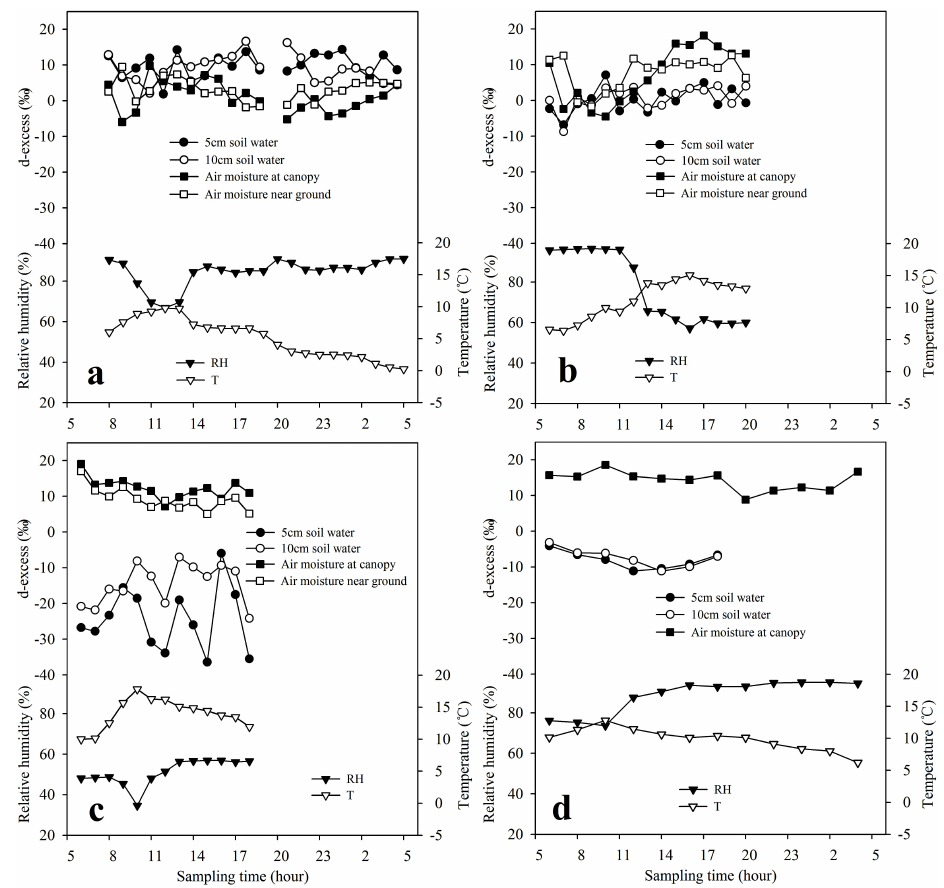
Figure 8. Variations in d-excess of shallow soil water and air moisture during the cloudy days of the upper reaches of the Heihe River basin. Note: panels (a) , (b) , (c) and (d) refer to the same locations as in Fig.